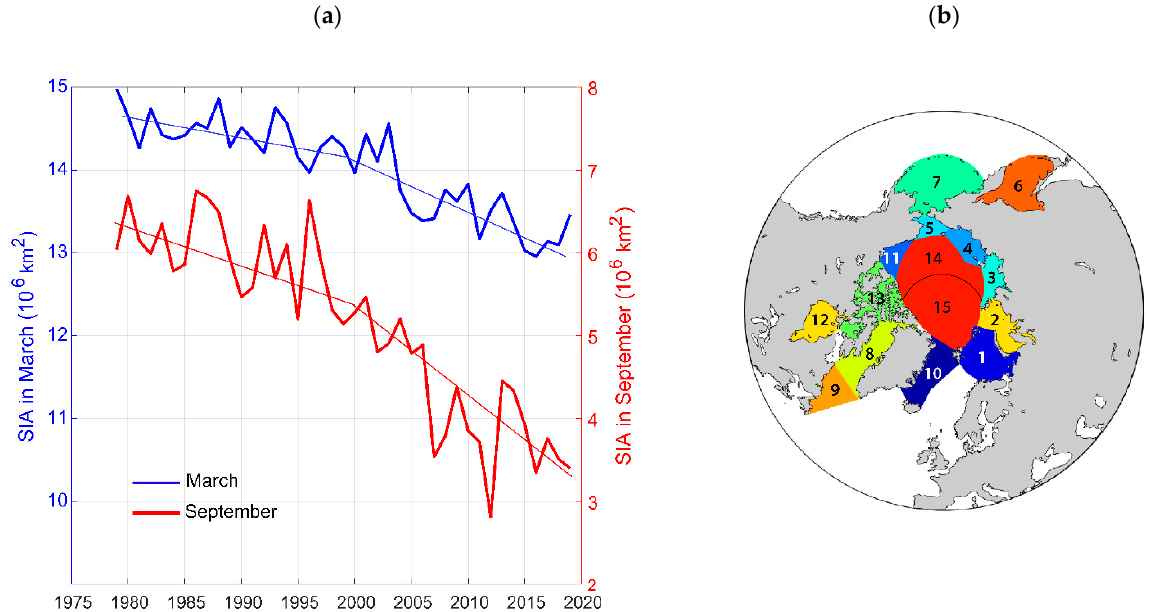
Figure 1. ( a ) Northern hemisphere SIA time series from 1979 to 2019 (based on ERA5 SIC data) for March (blue) and September (red) with linear trends for 1979–1999 and 2000–2019 periods. ( b ) The